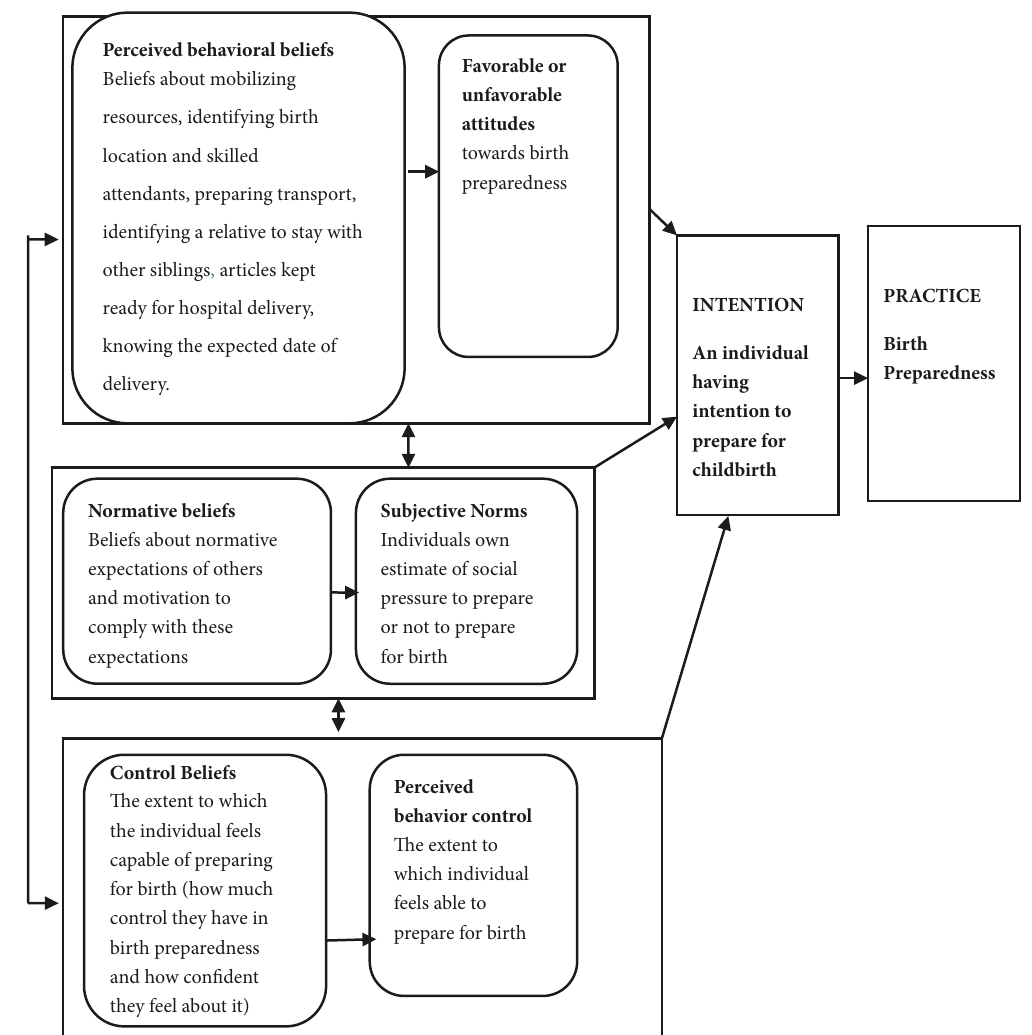
Figure 1: Theoretical framework of birth preparedness based on the Theory of Planned